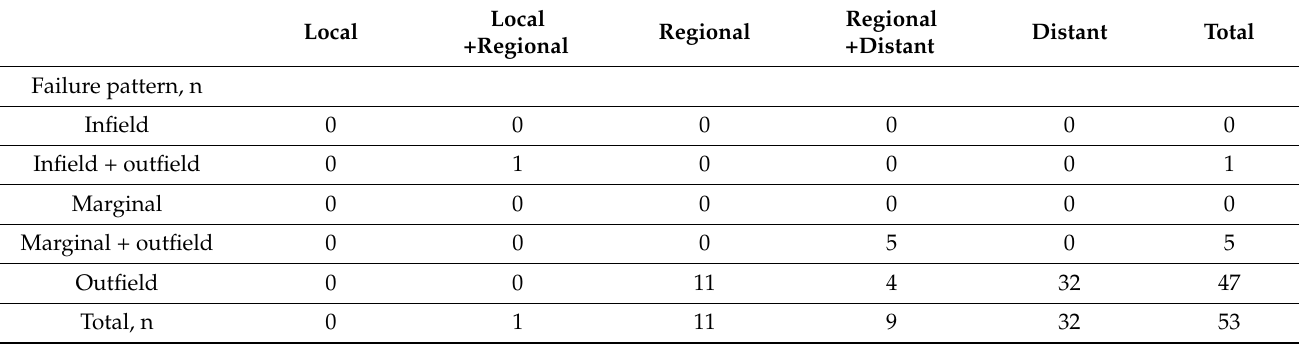
Table 3. Failure patterns according to ITMIG